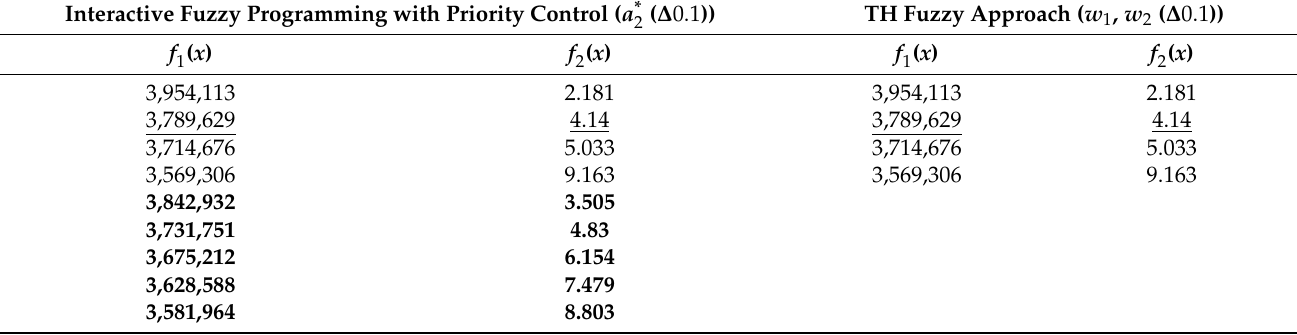
Table 6. Possible solutions of the problem by the TH fuzzy approach and the interactive fuzzy programming with priority control